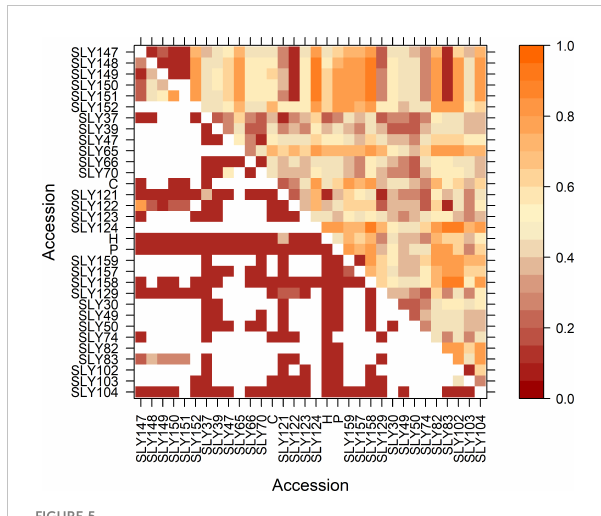
FIGURE 5 FST between pairs in the upper half triangle and p -value in the lower half for the evaluated accessions via 15 SSR. In white p - values ≤ 0.0001.